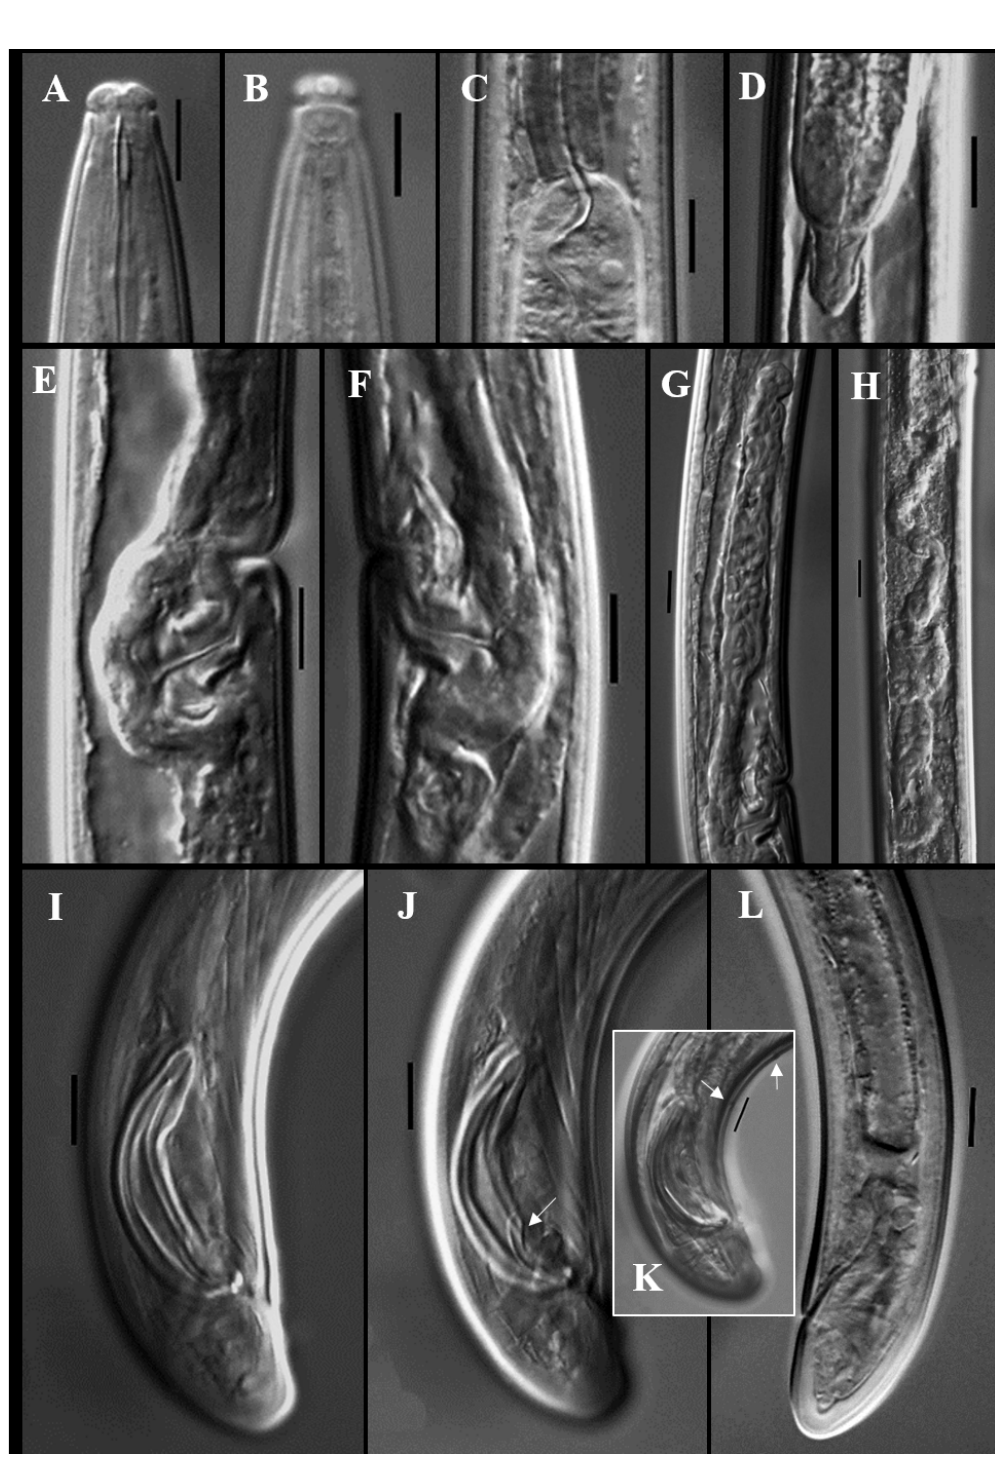
Fig. 10. Axonchium nilgiriense sp. nov. (LM photographs). A – D . Paratype ♀, (slide 2). E . Paratype 4, ♀. I – K . Paratype 5, ♂ (slide 4). F – H , L . Paratype 6, ♀ (slide 5). A . Anterior region. B . Anterior end showing amphid. C . Junction between two parts of the pharynx. D . Cardia. E – F . Vulva and vagina. G – H . Female genital branches. I . Male posterior end. J . Arrow indicating lateral guiding piece. K . Arrows indicating ventromedian supplements. L . Female posterior end. Scale bars =